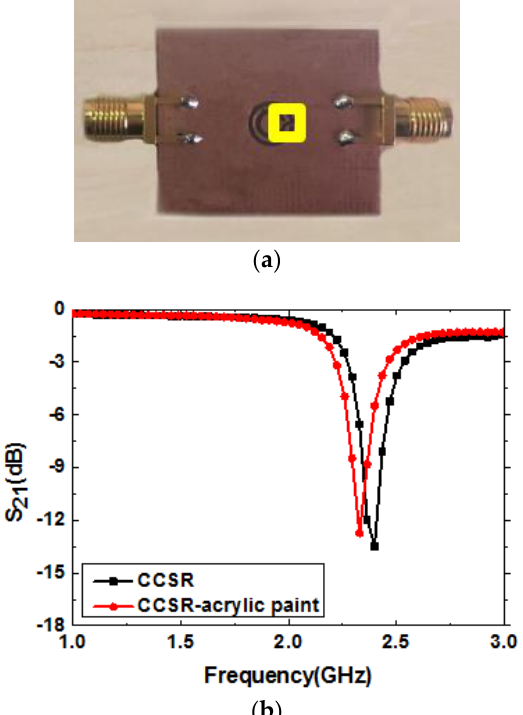
Figure 8. ( a ) Photograph of the post-processing sensor with the channel drawn by acrylic paint; ( b ) Measured resonance characteristics of the sensor with the channel drawn on the substrate.